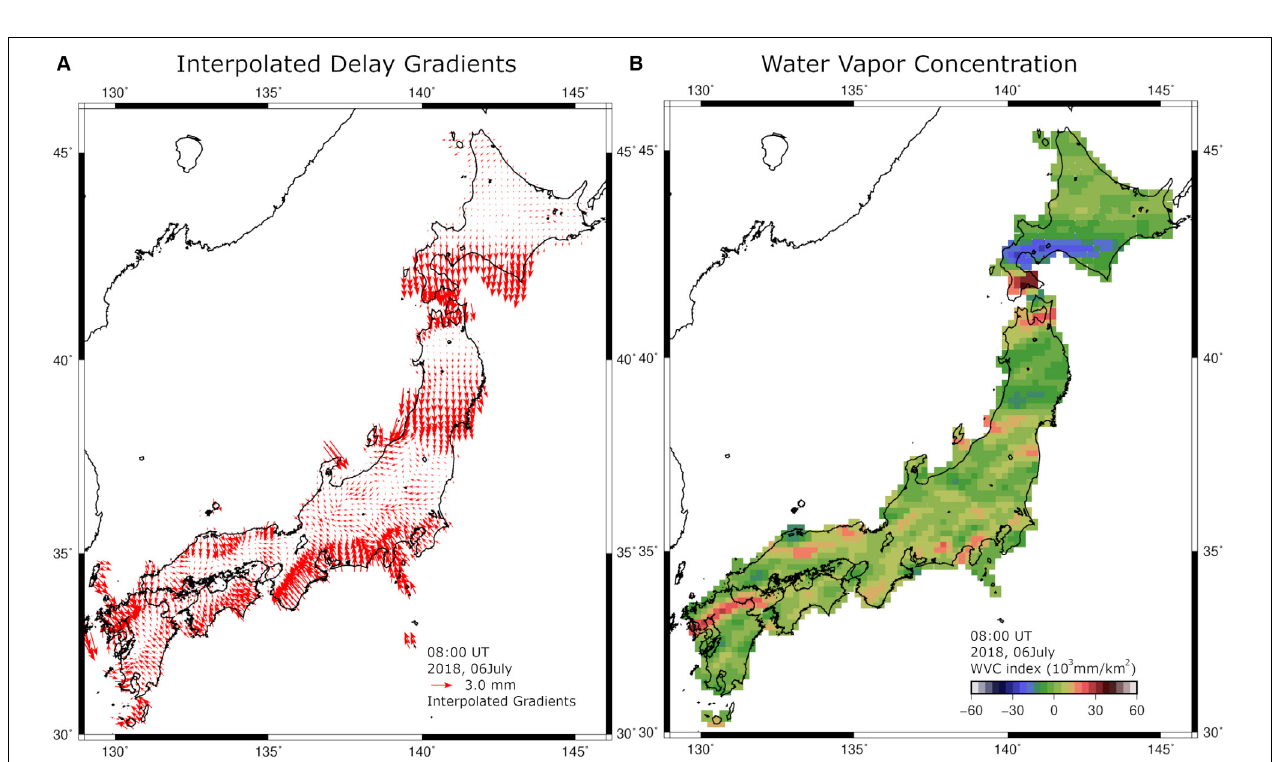
FIGURE 2 | (A) Atmospheric delay gradients at grid points at 17 JST (08 UT) on July 6, 2018 (raw gradient data are shown in Figure 4A ). Using these gradient vectors at grid points, we calculated their convergence shown in (B) , similar to WVC index defined by Shoji (2013).